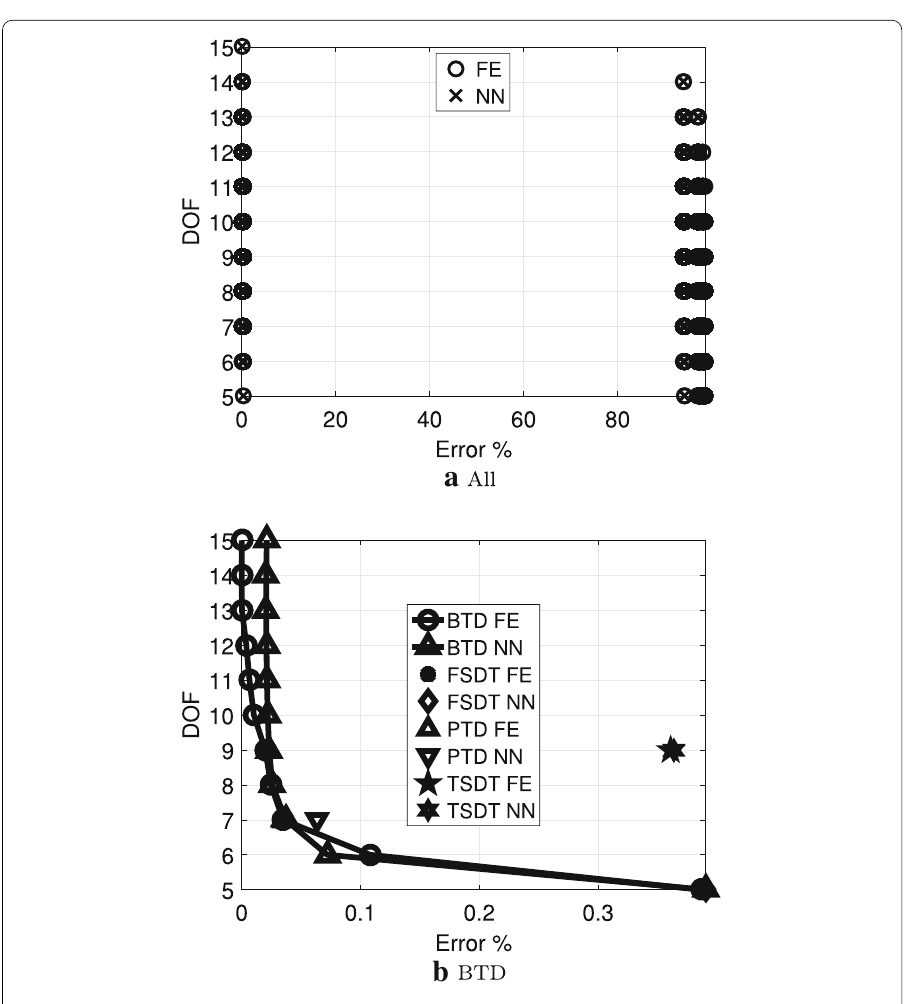
Fig. 13 FE and NN results for 0/90/0/90, a/h = 100, one layer with ten neurons